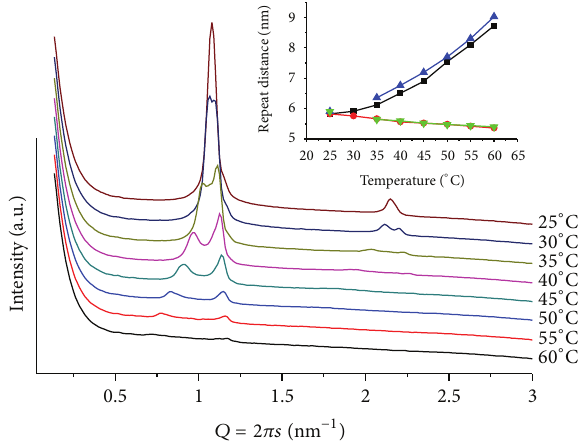
Figure 4: SAXS patterns at different temperatures for POPE/ANQ, mr = 50 and pH = 9 . Note the occurrence of the so-called Y sequence of patterns. Inlet: Repeat distances evolution for mixtures of POPE/additive, mr = 50 and pH = 9 , illustrating the microseg- regation into different lamellar arrangements. ( ∙ ) POPE/ANQ; the curves are fitted as: 𝑦 = 4.79 + 0.34 ∗ exp ( 𝑥 /24.24); 𝑅 2 = 0.995 (black)and 𝑦 = 6.13−0.0131∗𝑥 ; 𝑅 2 = 0.981 (red). (⧫) POPE/BANQ: